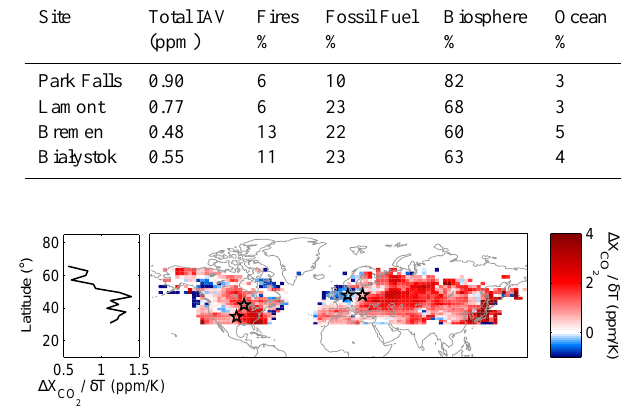
− δT slope over the 30–70 ◦ N re- Fig. 7. A map of the mean 1 X CO 2 gion from two summertime drawdown periods using GOSAT data. The TCCON stations involved in this study are indicated with black − δT stars. The panel on the left shows the zonal-mean 1 X CO 2 slope as a function of latitude. Note that the latitude scales are not the same for the left panel and map: the left panel is linear in lati- tude, while the map is a Miller